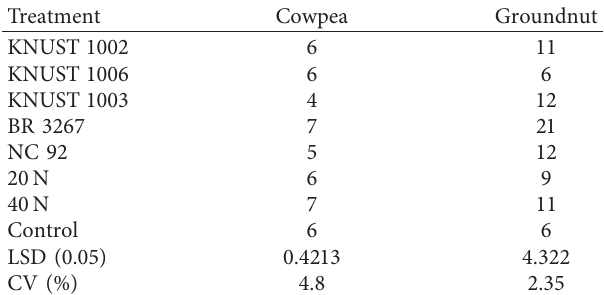
Table 3: Effects of rhizobial inoculation and N fertilizer application on pod numbers of cowpea and groundnut grown at Nyankpala in the Guinea Savanna zone of